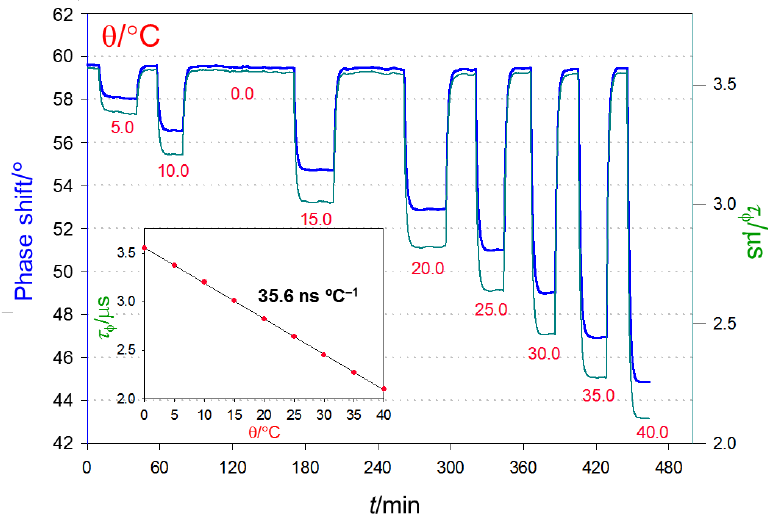
Figure 6. Temperature response of the Ru(phen) 2 (4-Clp) 2+ -doped poly(ethyl cyanoacrylate) luminescent optode fabricated with an initial concentration of dye in ethyl cyanoacrylate of 29 μM. The thick blue line represents the experimental raw data (phase shift) measured with the fiber-optic luminometer (excitation LED modulation f = 78 KHz). The corresponding emission lifetime (thin green line and inset), i.e., the experimental (average) value obtained from the phase shift angle ( τ φ = tan φ /2 π f ) displays a linear response in the 0 to 40 ◦ C range ( r = 0.99987), with a slope of 35.6 ns ◦ C − 1